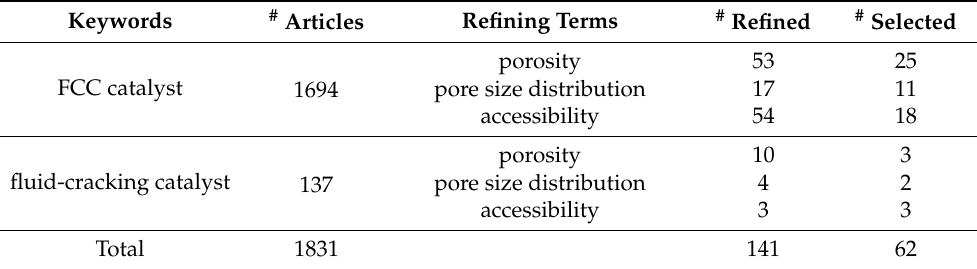
Figure 4. Number of articles published in top ten journals 1990–2020. A similar search was made using the Scopus database, resulting in Table 2. Table 2. Scopus results from 1990 to 2020.